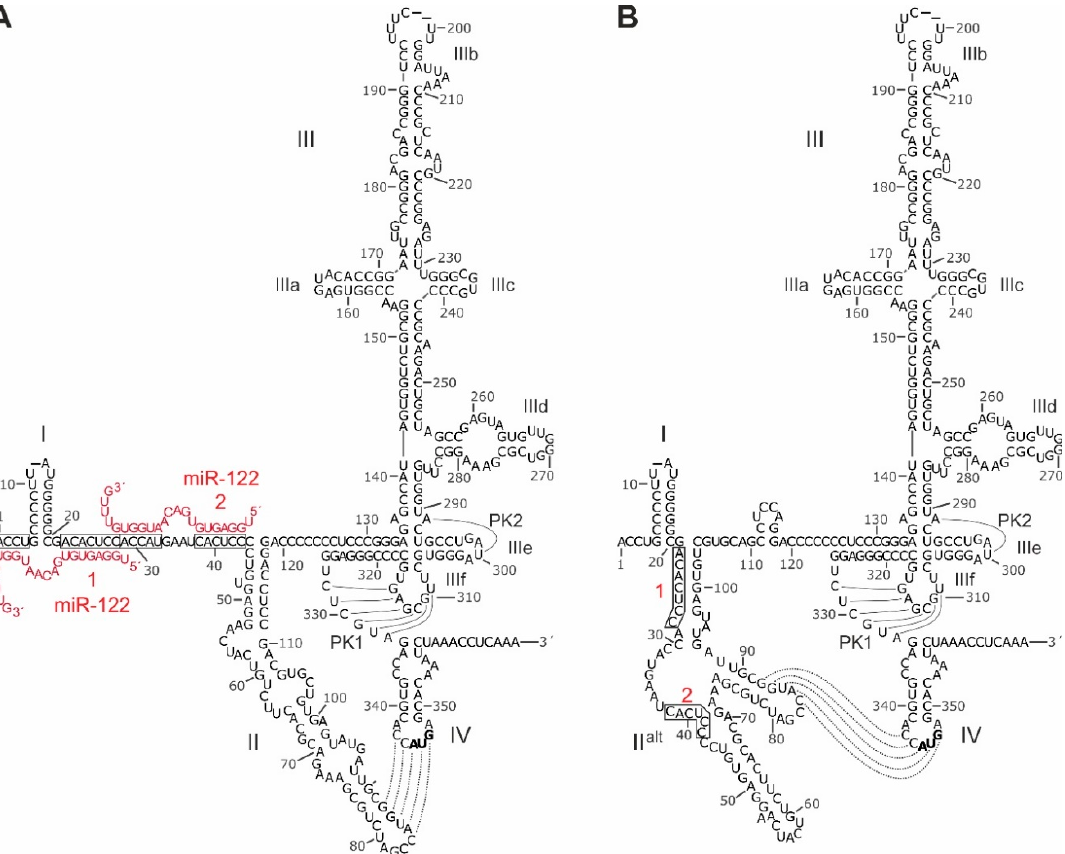
Figure 2. Sequence and RNA secondary structure of the HCV IRES. ( A ) The 5´UTR of HCV and its canonical structure [63,109–114]. The sequence shown is from genotype 2a (J6 isolate), with length variations among HCV isolates indicated by short horizontal dashes at nucleotide positions. Nucleotide numbering is according to the MAFFT alignment in the supplement of [63] (http://www.rna.uni-jena.de/supplements/hcv/). For comparison, the first nucleotide of the core coding sequence (AUG, in bold) in the SL IV is nucleotide No. 342 in genotype 1b (Con1) and No. 341 in genotype 2a (J6 and JFH1 isolates). IRES SL domains are indicated by roman numerals. microRNA-122 (miR-122, red) binding is indicated, miR-122 target sequences are boxed. Pseudoknot (PK) base pairing and the interaction between SL II and SL IV is indicated; ( B ) Secondary structure model of the 5´UTR with alternative folding of SL II alt . The structure is largely according to [72,77,115], with minor modifications according to our RNAalifold outputs using several genotypes (not shown).